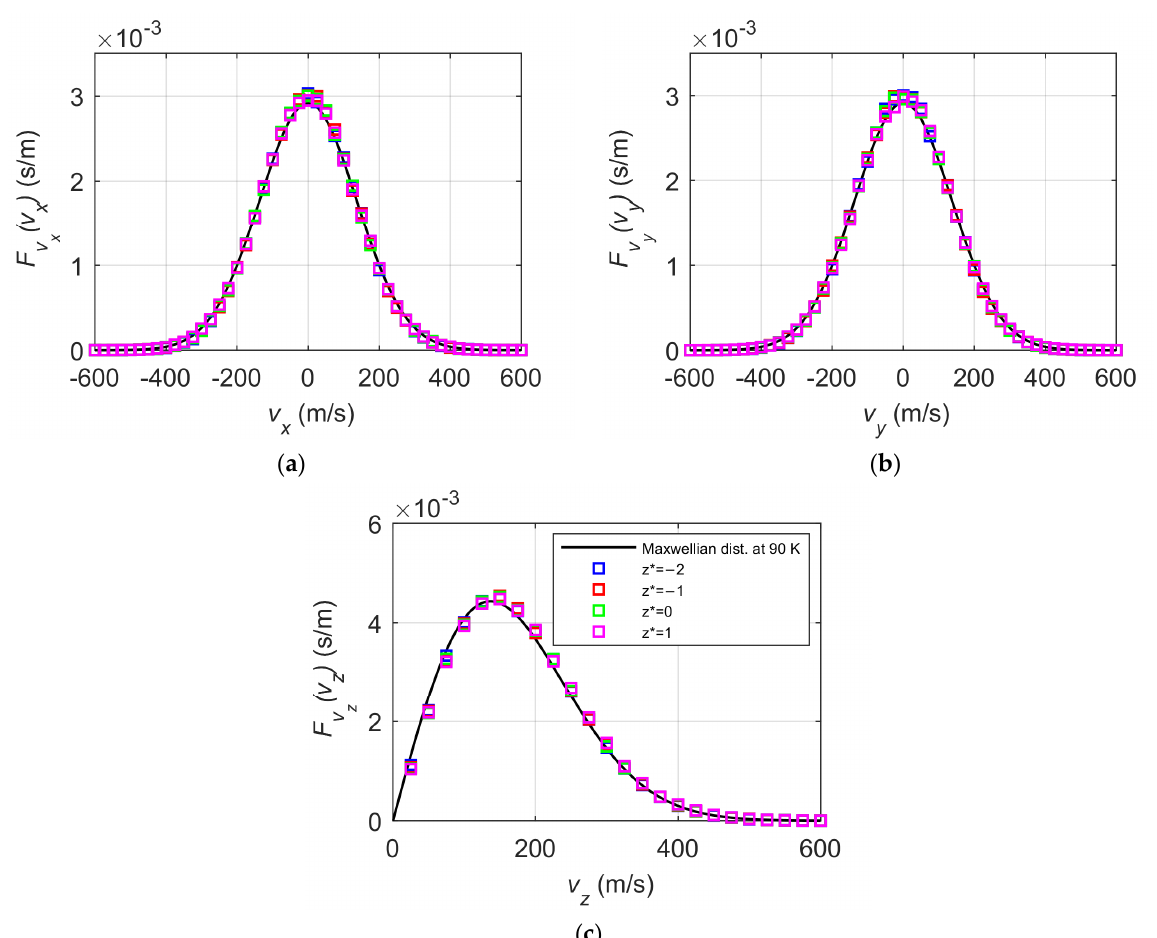
Figure 10. The average kinetic energy components in x , y , and z axis of evaporating argon atoms as a functions of normalized thermostat boundary position at the right-side interface.